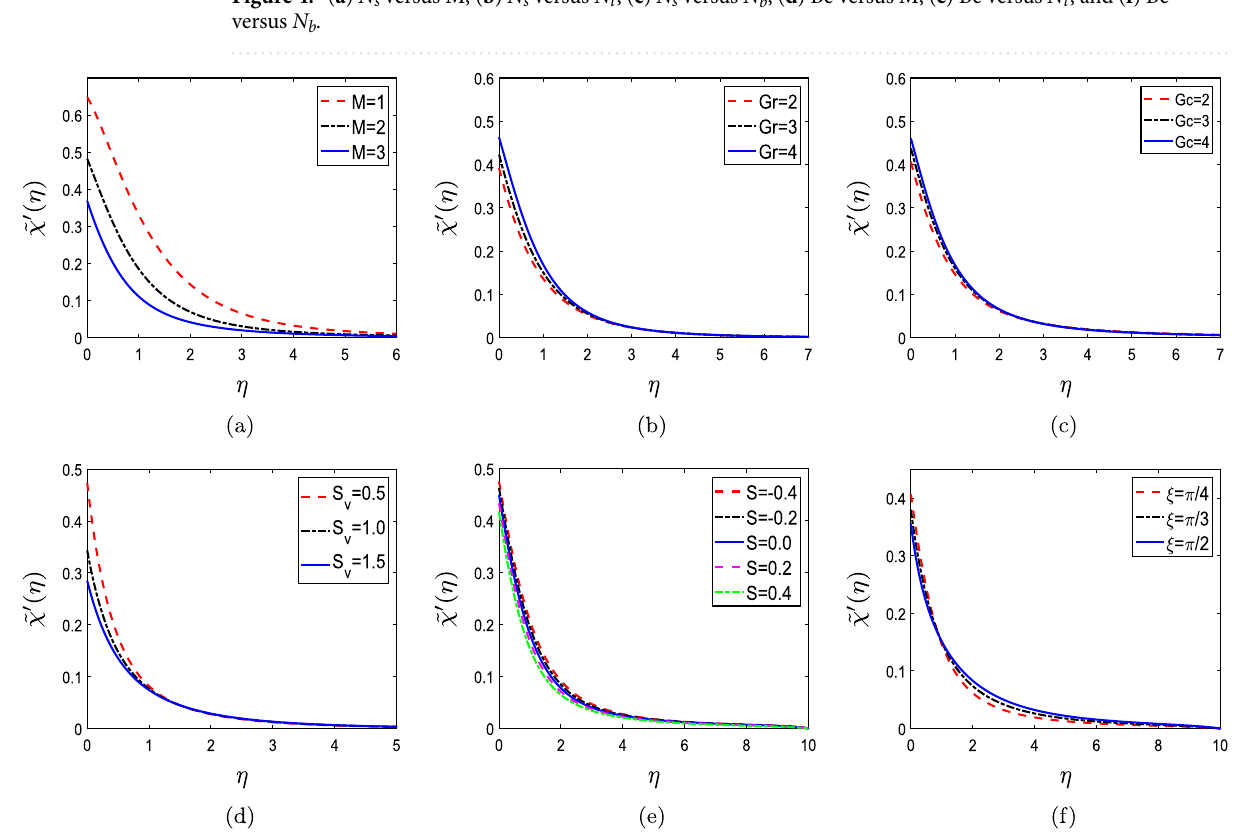
Figure 5. Non-dimensional velocity profiles for ( a ) Hartmann number (M), ( b ) Grashof number (Gr), ( c ) solutal Grashof number (Gc), ( d ) velocity slip ( S v ), ( e ) suction parameter (S), and ( f ) inclination parameter ( ξ